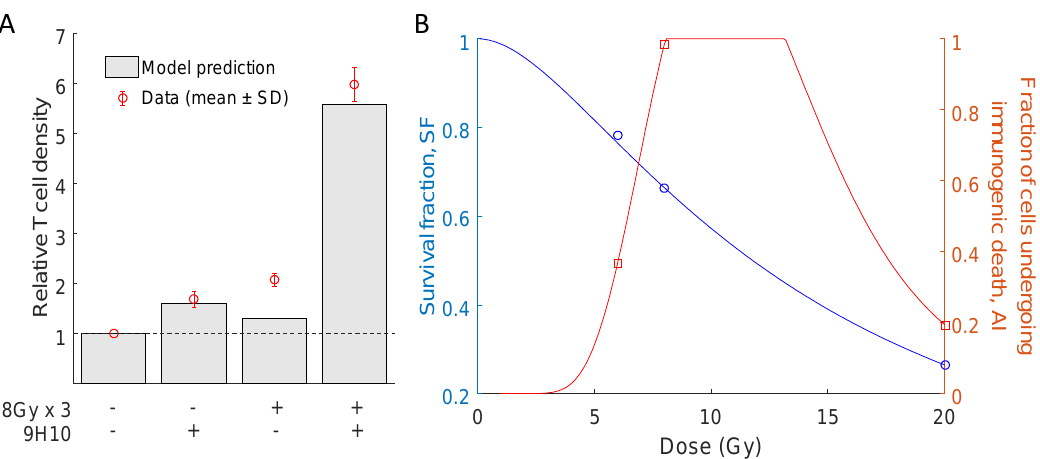
Figure 3. Comparison of relative T cell density and radiation response curves. ( A ) Model simulated and experimentally measured changes in immune cell infiltration at the secondary tumor site after the combination of radiotherapy and 9H10 immunotherapy. ( B ) Proposed interpolation of the model estimated radiation survival fraction ( SF D ) and proportion of cells undergoing immunogenic cell death ( AI D ) for radiation doses D = 6, 8 and 20 Gy (see Table 1) using Equations (1) and